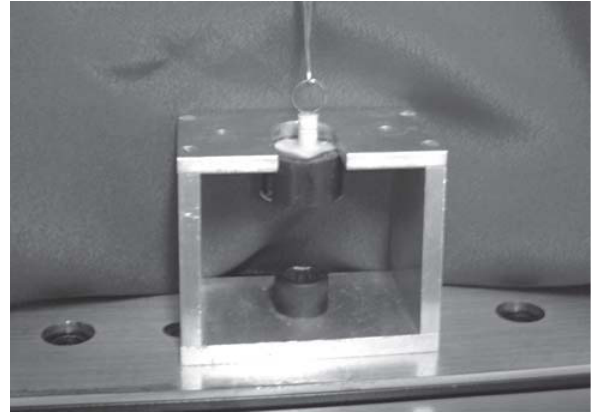
FIGURE 2- Specimens subjected to bond strength